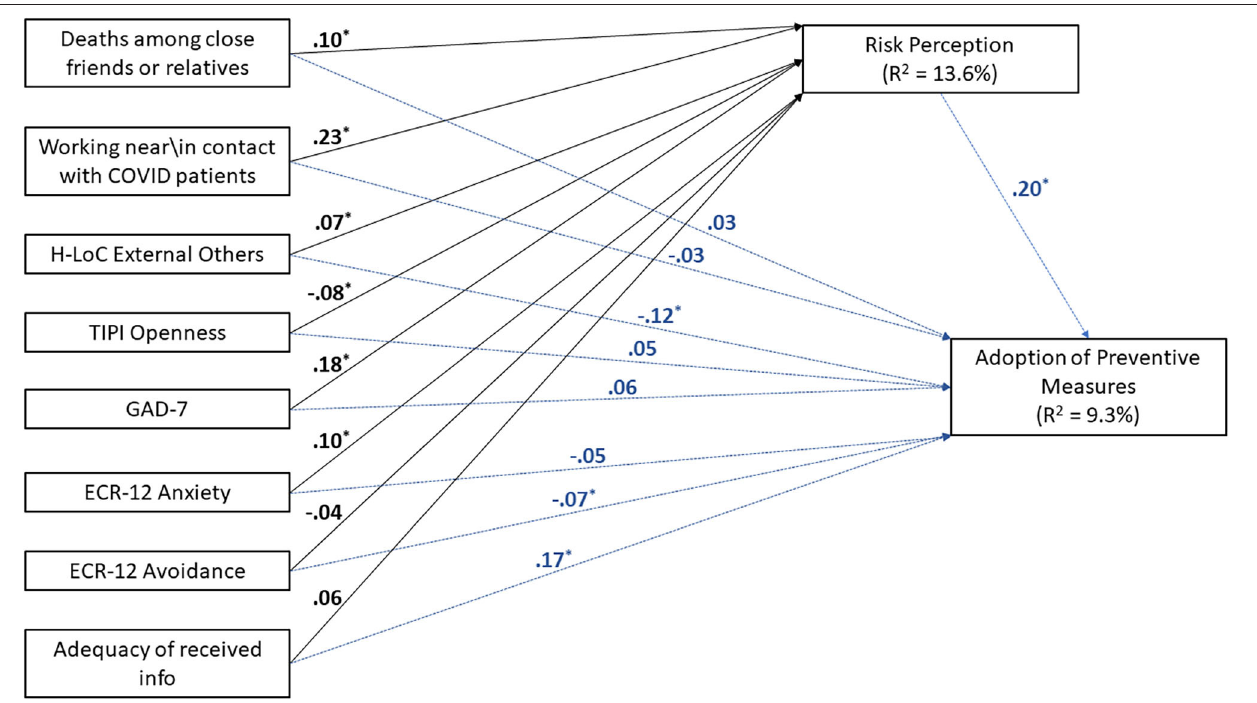
FIGURE 1 | Standardized direct paths of the mediation model (N = 907). Dashed blue lines (and blue parameters) represent the direct paths of all IVs on the dependent variable “Adoption of Preventive Measures.” Regarding indirect effects, the variables (others) health-related locus of control, anxious symptoms, attachment anxiety, working near/in contact with COVID-19 patients, and having experienced one or more deaths among close friends or relatives (due to COVID) had a significant, positive indirect effect on the adoption of preventive measures through risk perception, while openness had a significant indirect negative effect on the dependent variable (see Supplementary Table 6 for more information). H-LoC = Health-related Locus of Control scale; TIPI = Ten-Item Personality Inventory; GAD-7 = General Anxiety Disorder Scale–7; ECR-12 = Experiences in Close Relationships −